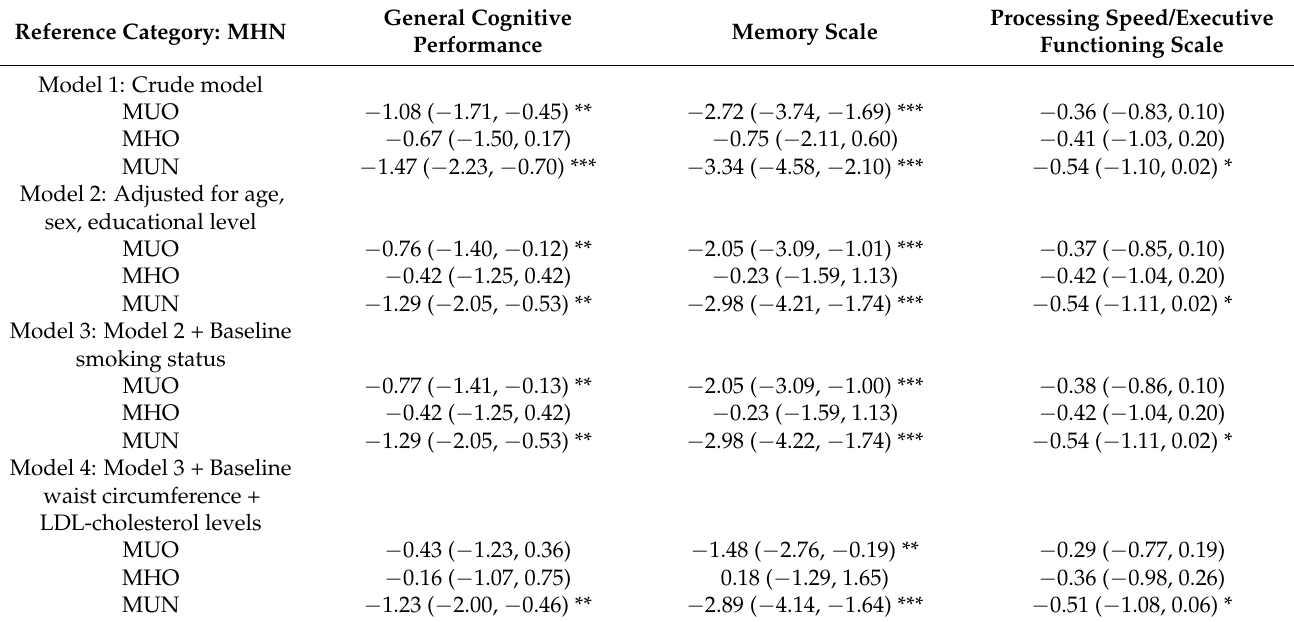
Table 3. Results from the mixed- effects linear models regarding the association of baseline partici- pants’ obesity and metabolic health status with cognitive time trajectories.